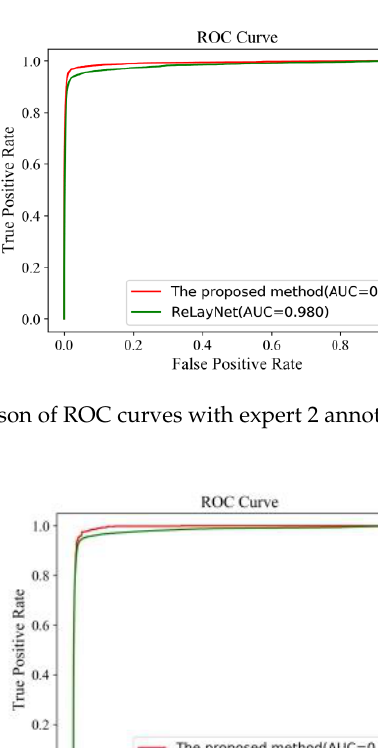
Figure 19. Comparison of ROC curves around fovea edema regions for expert 2 annotations as the ground truth.